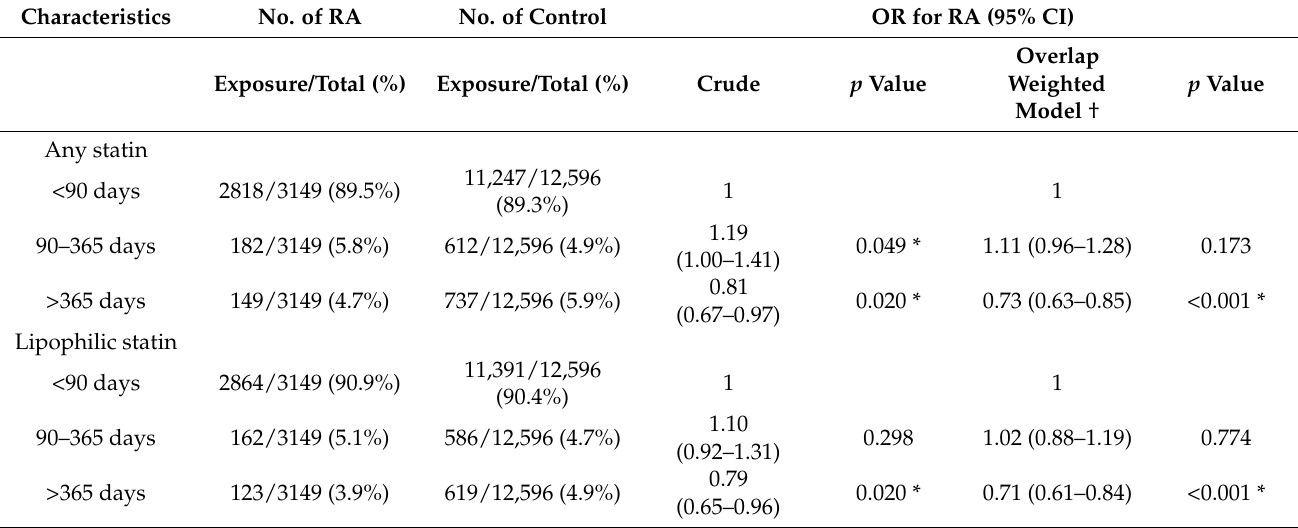
Figure 2. Forest plots depicting the association between use duration of any statin and a subsequent risk of incident rheumatoid arthritis (RA) in each subgroup. Table 2. Crude and adjusted odds ratios of statin types and use duration for RA.